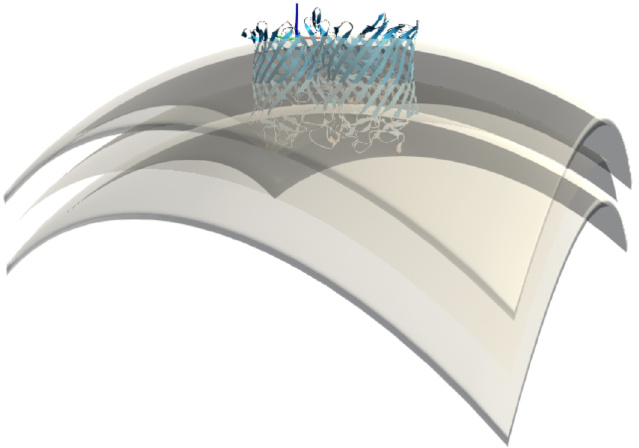
Figure 5. Illustration of maltoporin within a curved membrane reference mesh representing the centre of the bilayer, with both headgroup regions shown as thickened slabs in UnityMol.